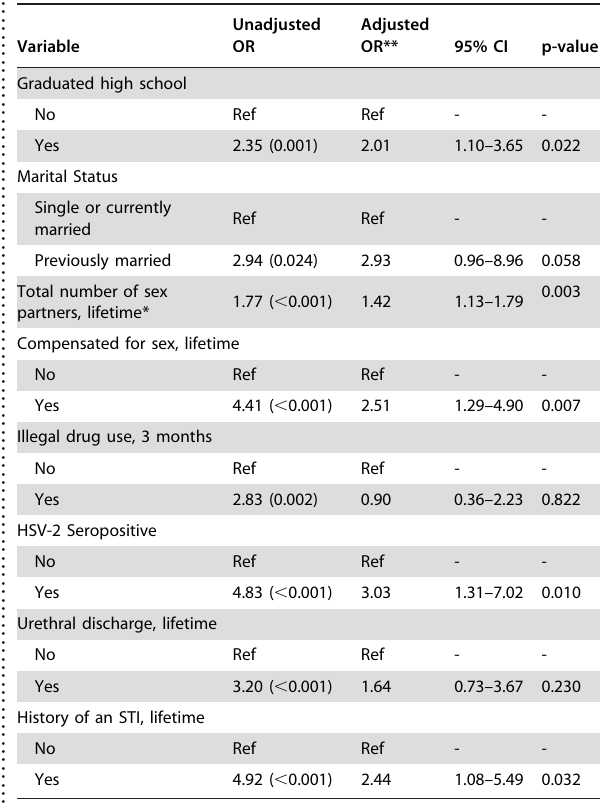
Table 3. Multivariate analysis of socio-demographic and risk behavior characteristics associated with MESM behavior among general population men: Lima, Chiclayo, and